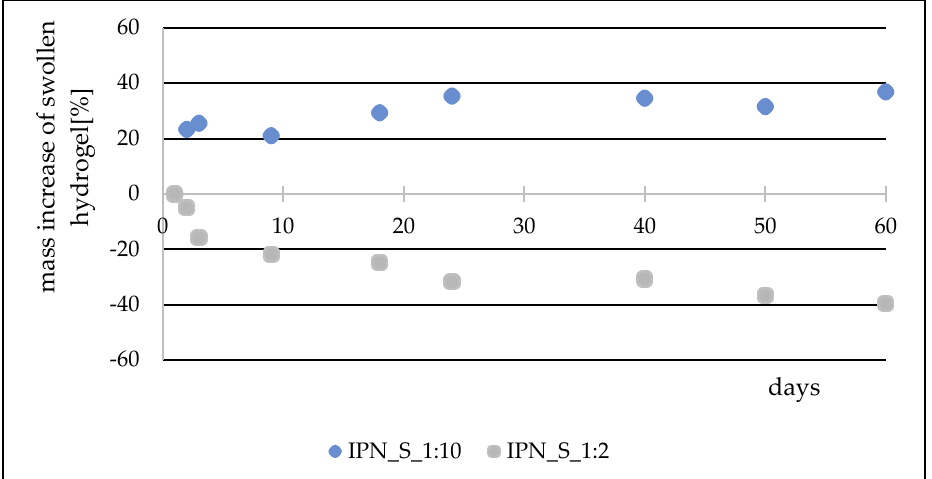
Figure 6. Water regain changes in PMEP over a two-month period.